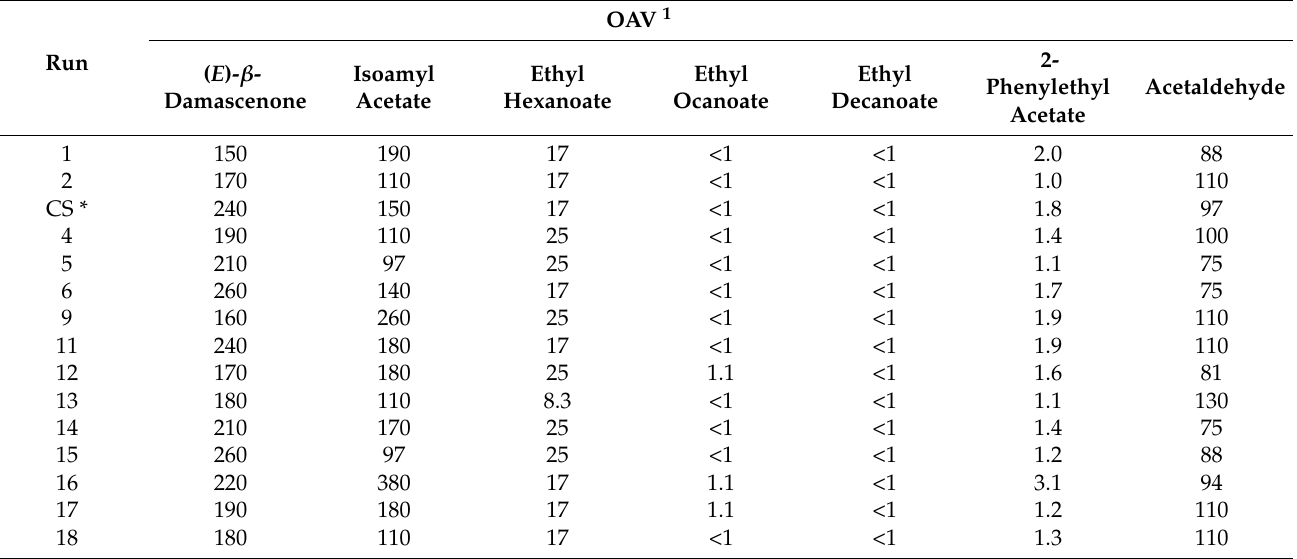
Table 8. Odor activity values (OAV) of the flavor compounds ( E )- β -damascenone, isoamyl